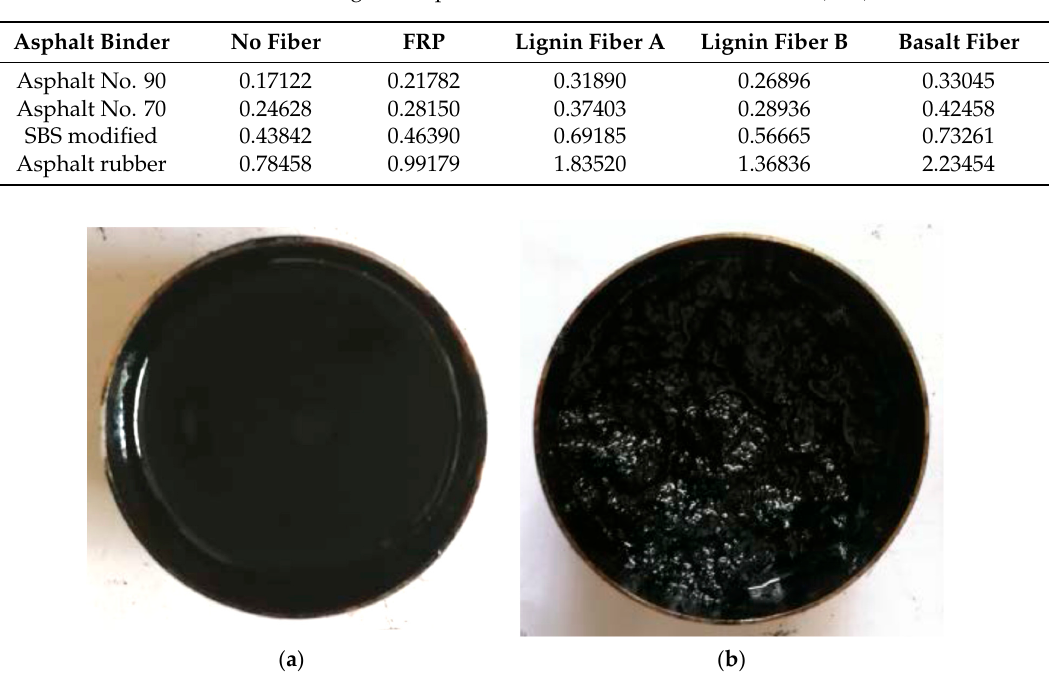
Figure 3. Typical surface of fiber-reinforced asphalt: ( a ) normal; ( b ) agglomeration.